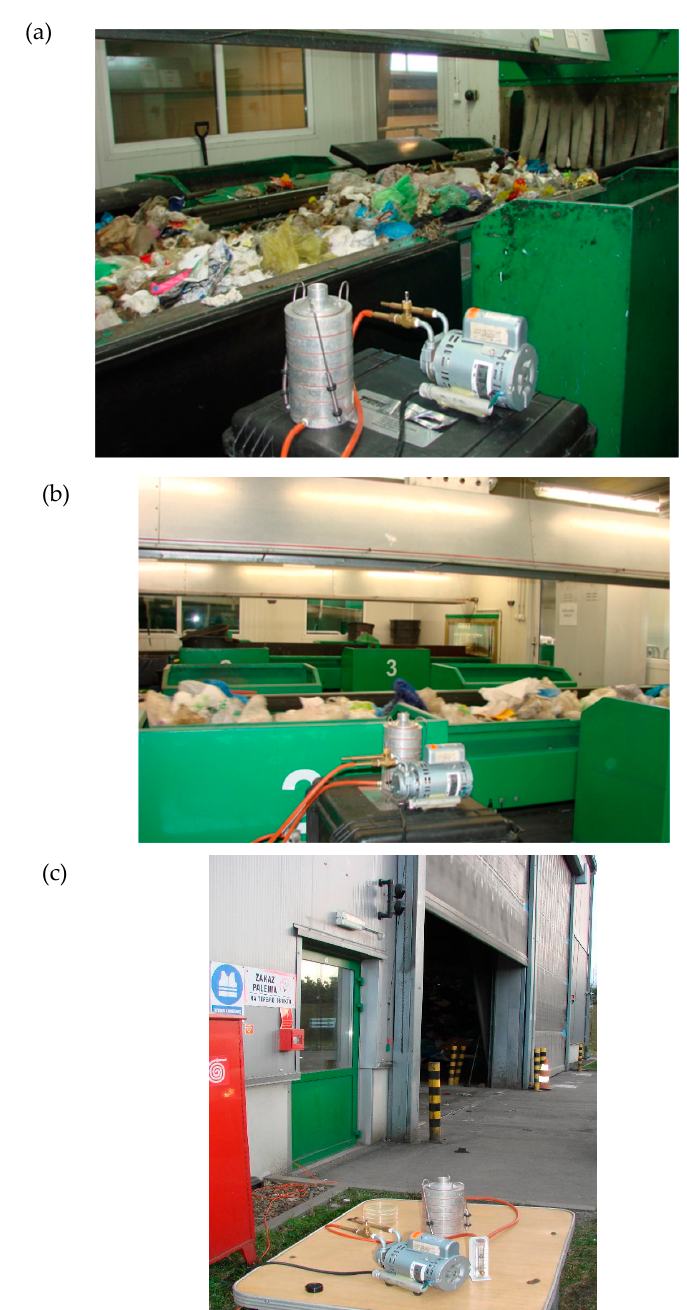
Figure 1. Six-stage Andersen Cascade Impactor (ACI) used during measurements in ( a ) preliminary manual sorting cabin (PSP), ( b ) a purification manual sorting cabin (quality control) (QCSP), and ( c ) outside the analyzed building (OUT).